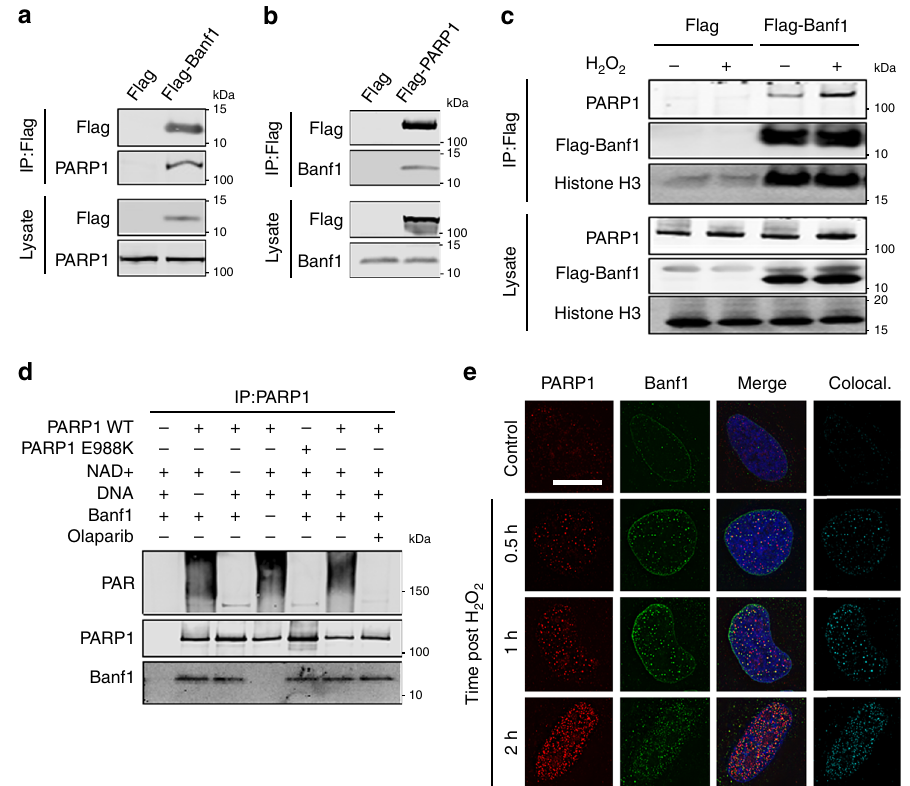
Fig. 2 Banf1 binds to PARP1 following oxidative stress. a , b Banf1 and PARP1 are in a complex; immunoprecipitations from HEK293T cells expressing Flag, Flag-Banf1 or Flag-PARP1 using Flag antibodies. Immunoprecipitates were immunoblotted with the indicated antibodies. c The Banf1:PARP1 interaction after H 2 O 2 ; immunoprecipitations from HEK293T cells ectopically expressing Flag or Flag-Banf1 1 h after H 2 O 2 removal. Immunoprecipitates were immunoblotted with the indicated antibodies. d Banf1 and PARP1 directly interact. The indicated puri fi ed proteins (±NAD + /DNA/olaparib) were incubated together before immunoprecipitation with PARP1 antibodies and immunoblotting with the indicated antibodies. e Banf1 and PARP colocalise following oxidative stress induced by H 2 O 2 in U2OS cells. Representative cells fi xed at the indicated times following removal of H 2 O 2 and stained with the indicated antibodies are shown, the colocalisation was analysed using ImageJ. The scale bar represents 10 μ m. Immunoblots are representative of three independent experiments. Source data are provided as a Source Data fi